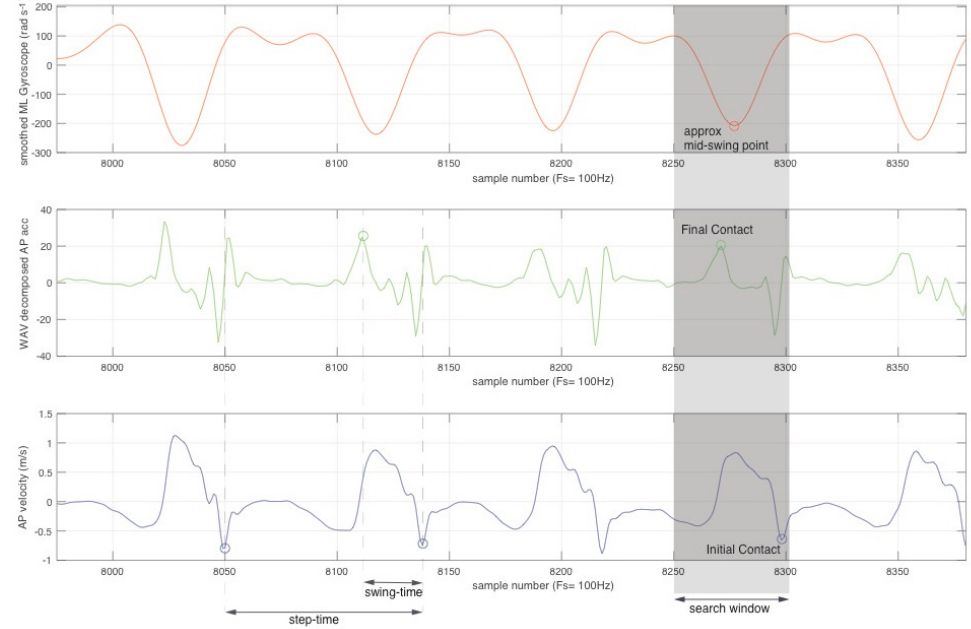
Figure 4. Transformed signal traces and diagrammatic representation of how FC and IC events are detected. From the FC and IC events, step-time and swing-time can be inferred.